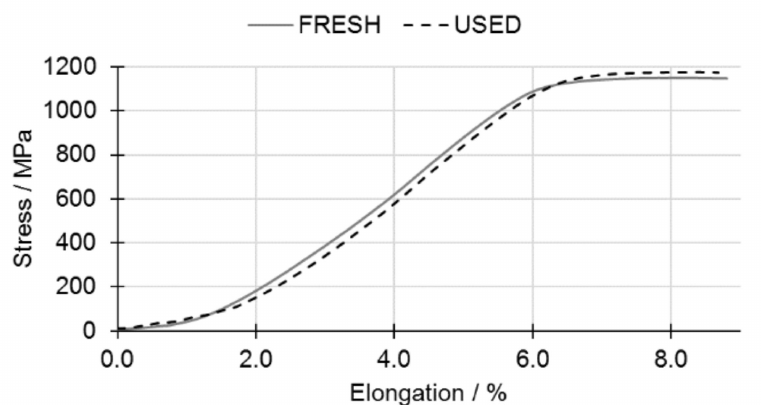
Figure 12. Comparison of the tensile behavior of 3D-printed samples from FRESH Ti6Al4V powder (solid line) and USED Ti6Al4V powder (dashed line).